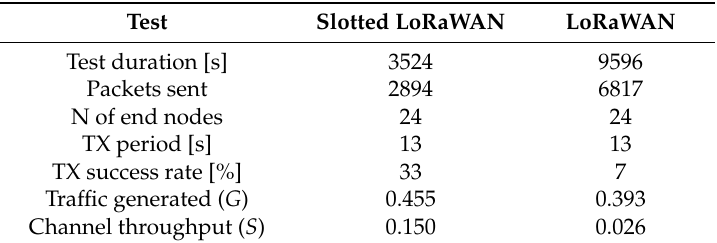
Table 3. Comparison between LoRaWAN and Slotted LoRaWAN.